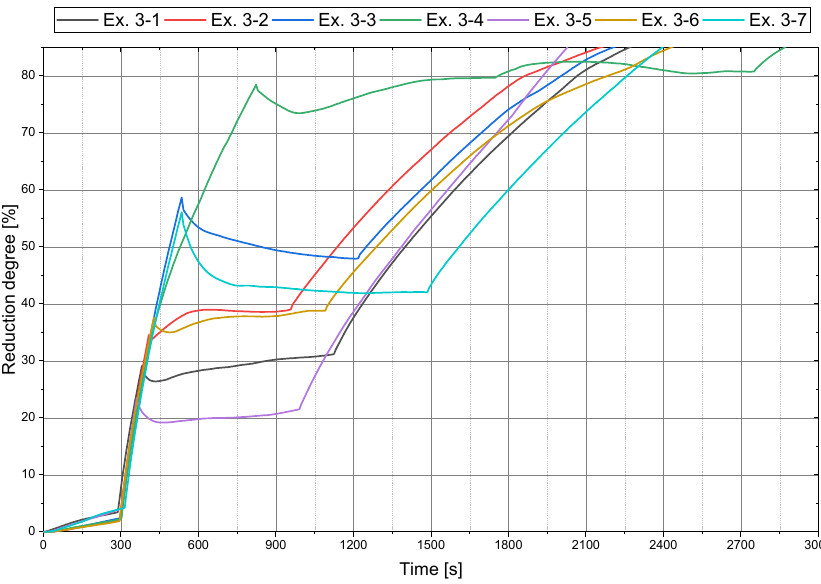
Figure 7. Reduction trend for the main trials.